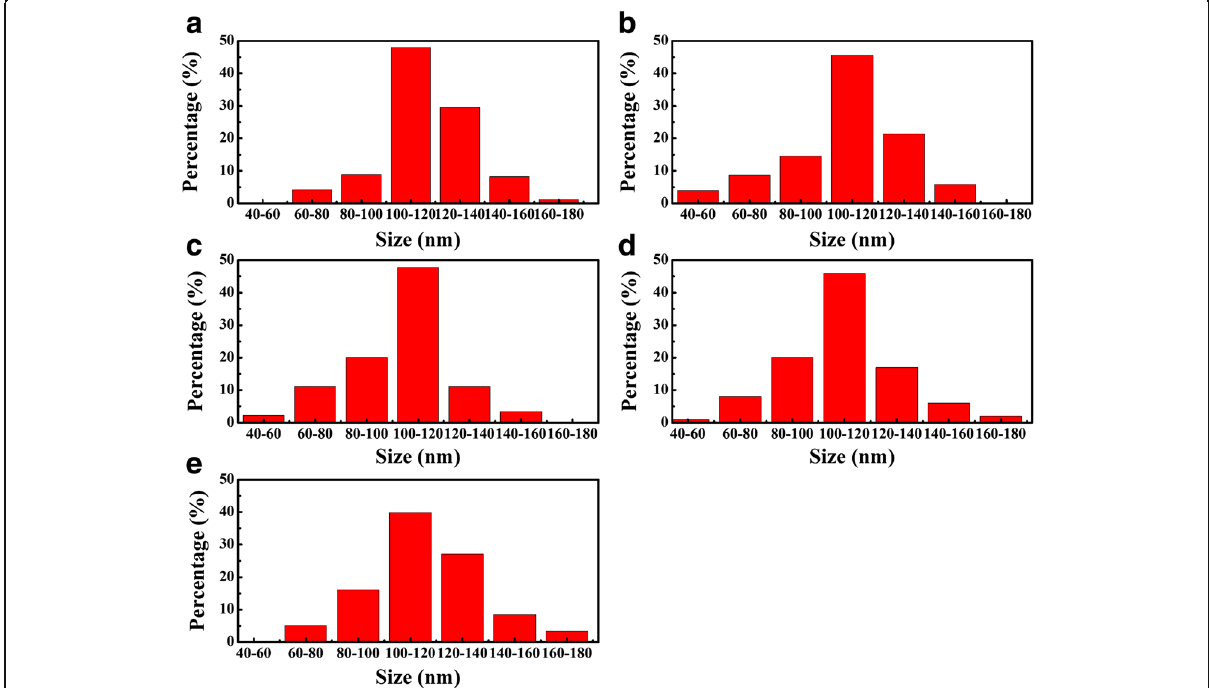
Fig. 4 The distribution of pit size for the five samples: a S 1 , b S 2 , c S 3 , d S 4 , and e S